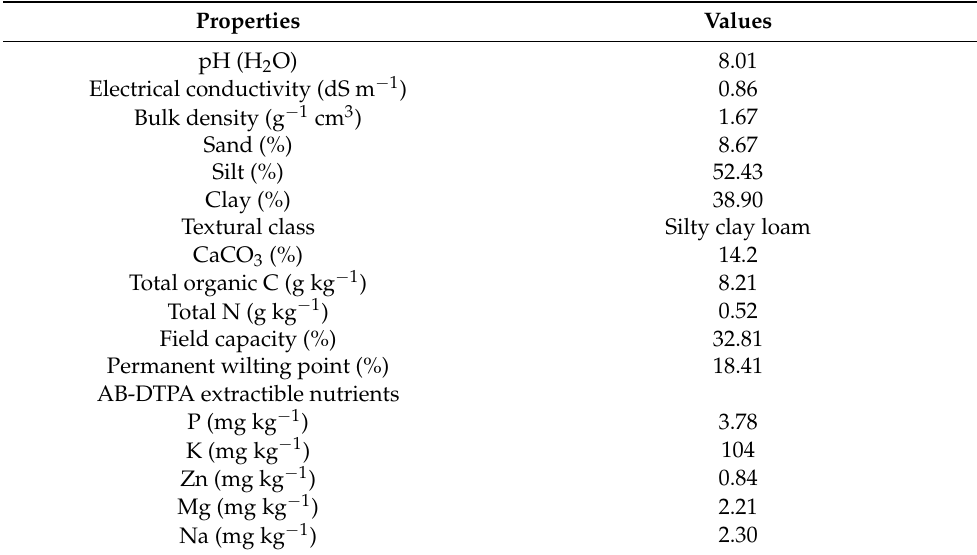
Table 1. Physico-chemical properties of soil at the experimental